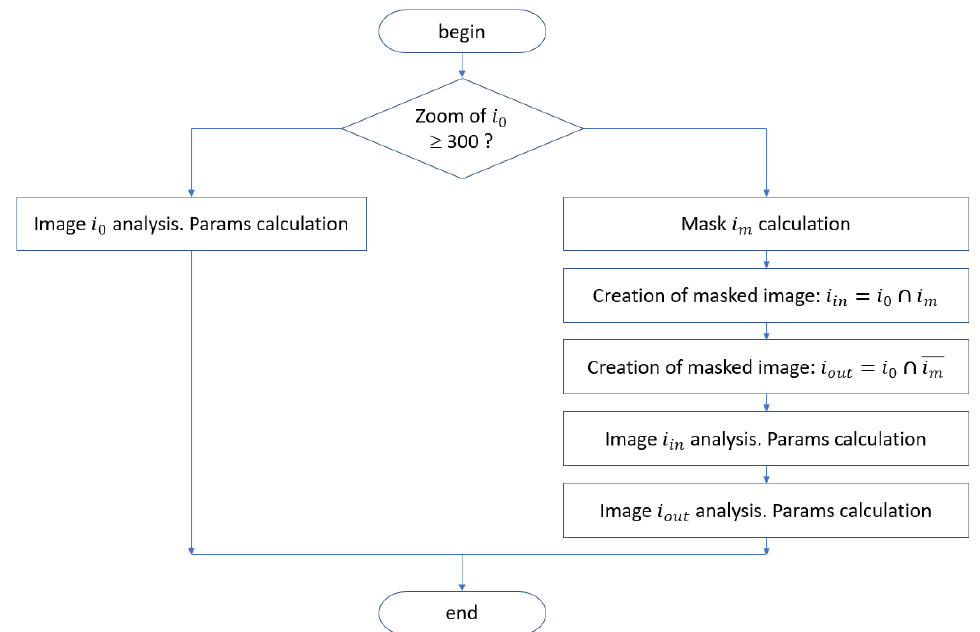
Figure 7. Algorithm for analysis of fractograms of titanium alloy VT23M depending on their magnification.